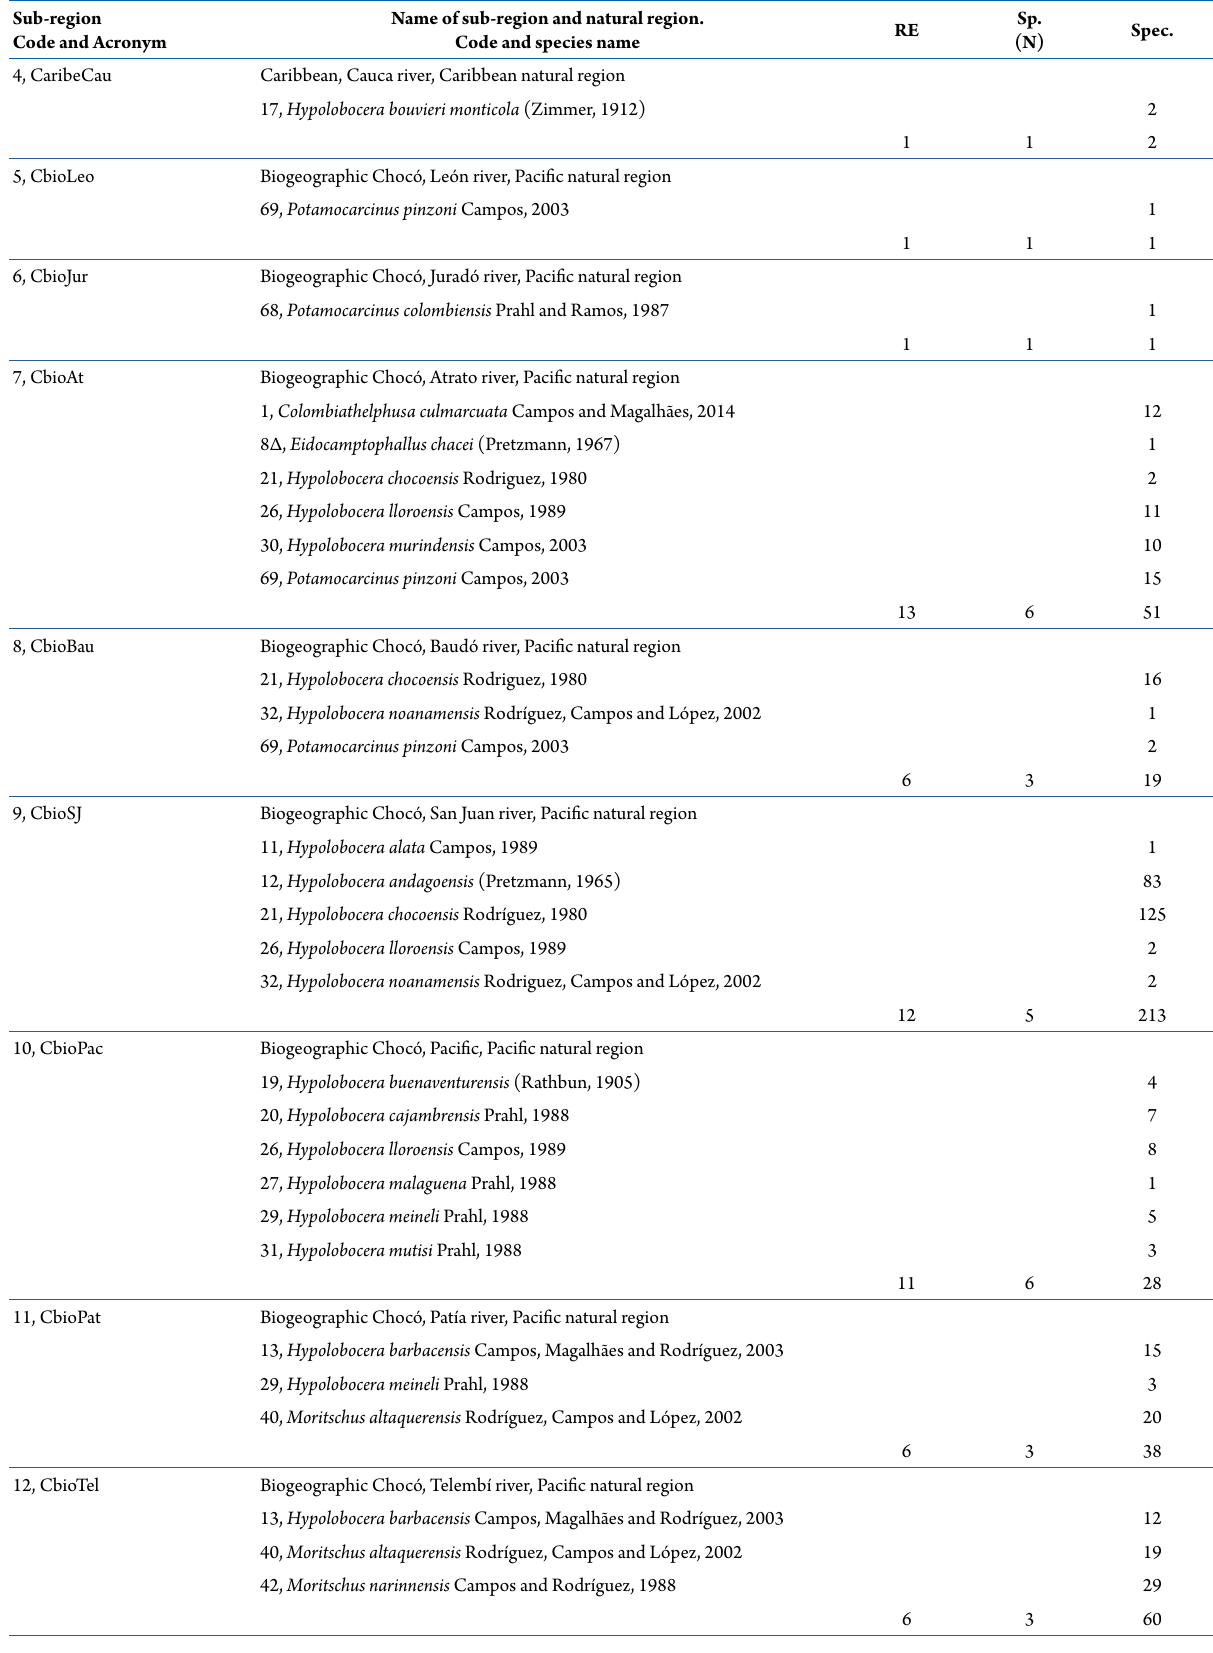
Table 2. Cont. Sub-region Code and Acronym